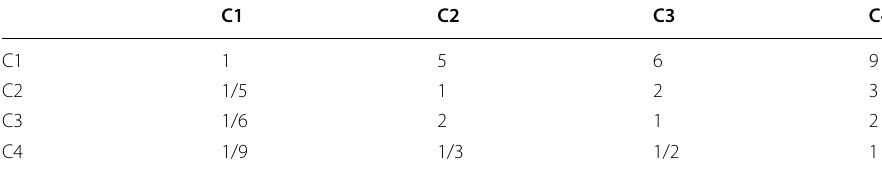
Table 3 Pair wise comparison